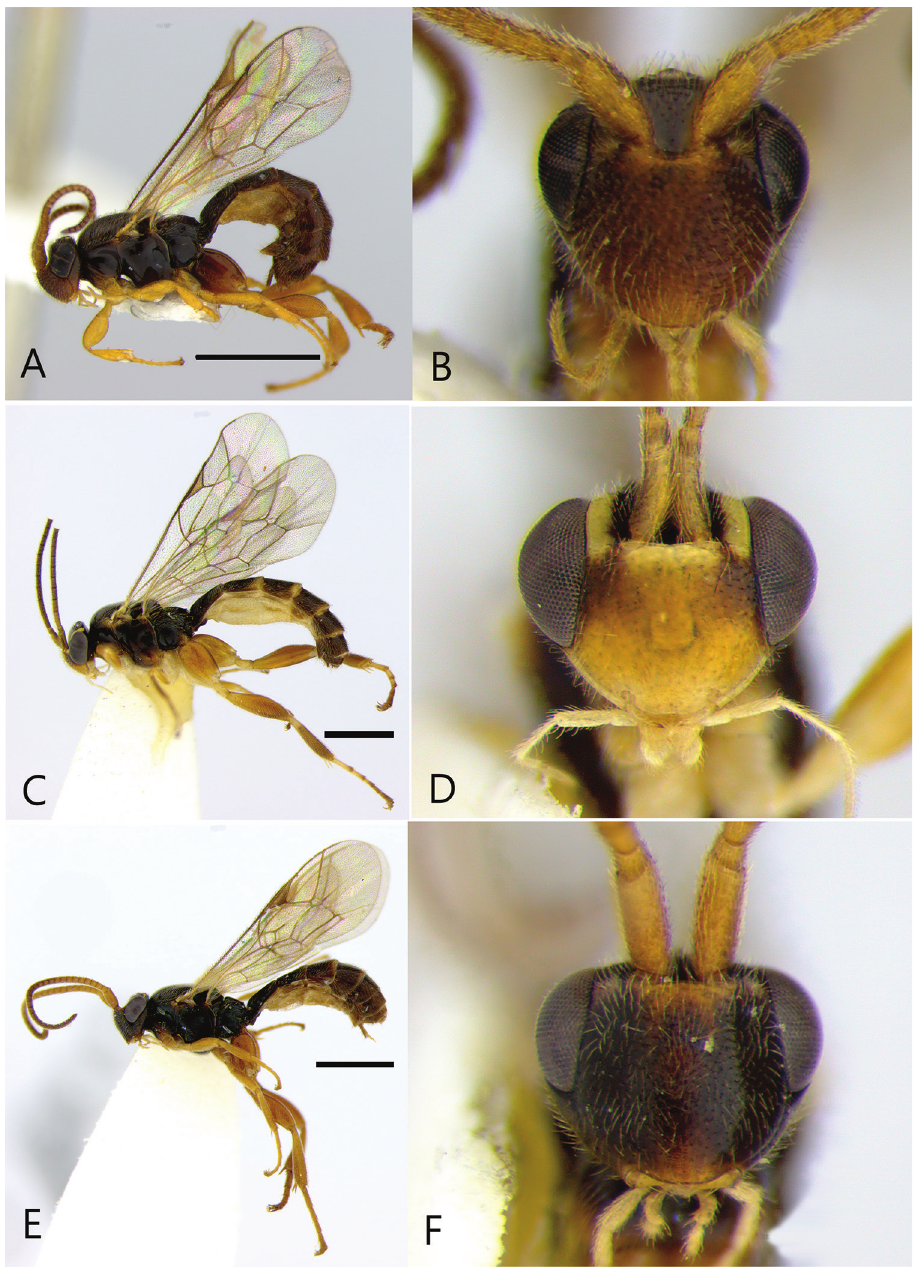
Figure 1. Orthocentrus spp. A Habitus in lateral view of O. asper B head in frontal view of O. asper C habitus in lateral view of O. castellanus D head in frontal view of O. castellanus E habitus in lateral view of O. fulvipes F head in frontal view of O. fulvipes